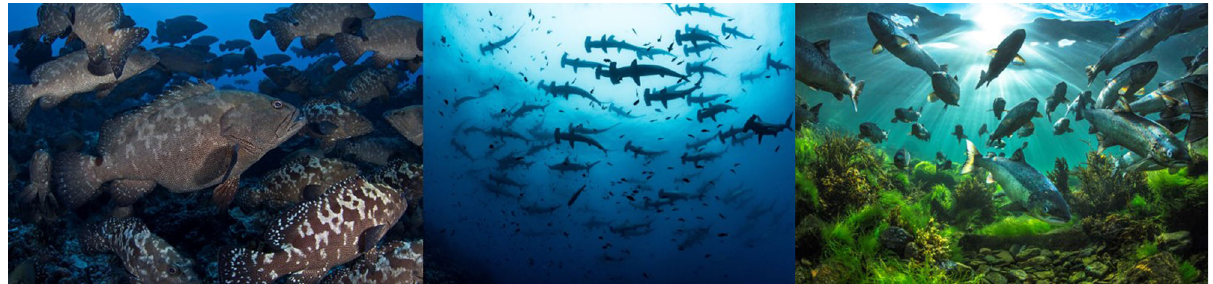
Fig. 1 The social lives of fi sh. Examples of fi sh species of conservation concern that may bene fi t from the use of social network analysis such as (from left to right) spawning marbled groupers ( Epinephelus polyphekadion ), schooling scalloped hammerhead sharks ( Sphyrna lewini ), or Atlantic salmon ( Salmo salar ). Photo credits: marbled grouper by T. Vignaud, scalloped hammerhead sharks by S.J. Pierce and Atlantic salmon by A. Rikardsen. All photos published with permissions from authors.